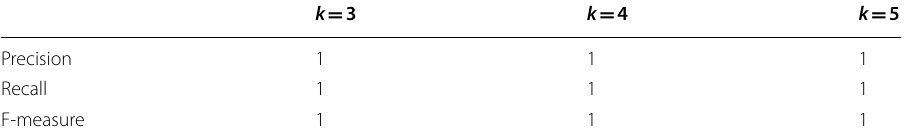
Table 16 Performance of Jaccard coefficient in detecting near-duplicate documents (WebKB_NDD) k 3 k 4 k 5 = = = Precision 0.9259 1 1 Recall 1 1 1 F-measure 0.9616 1 1